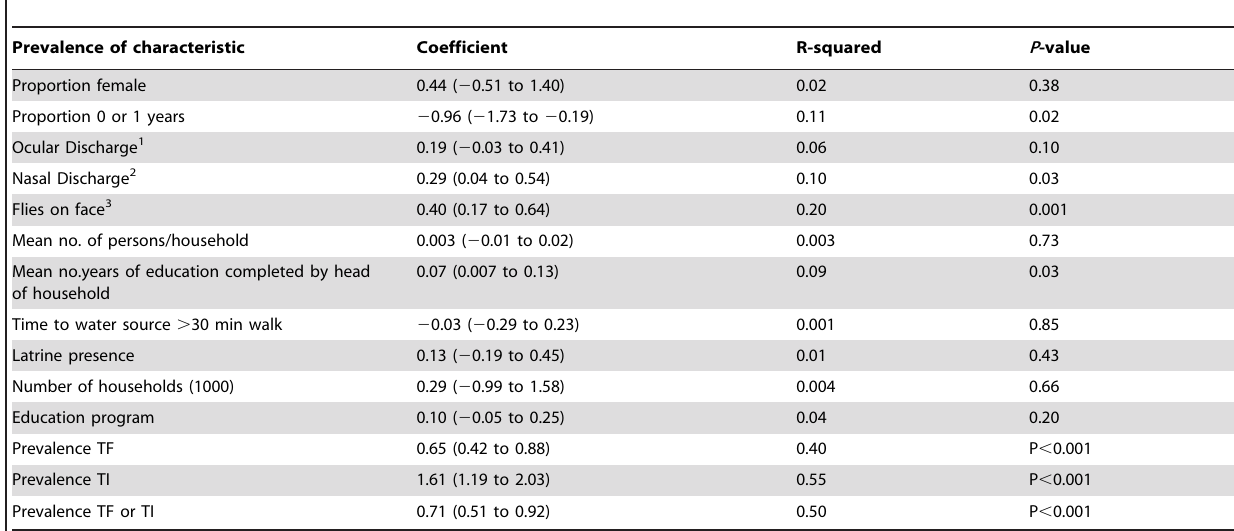
Table 3. Univariate analysis of chlamydia infection predictors in children 0–5 years in 48 communities in Niger.